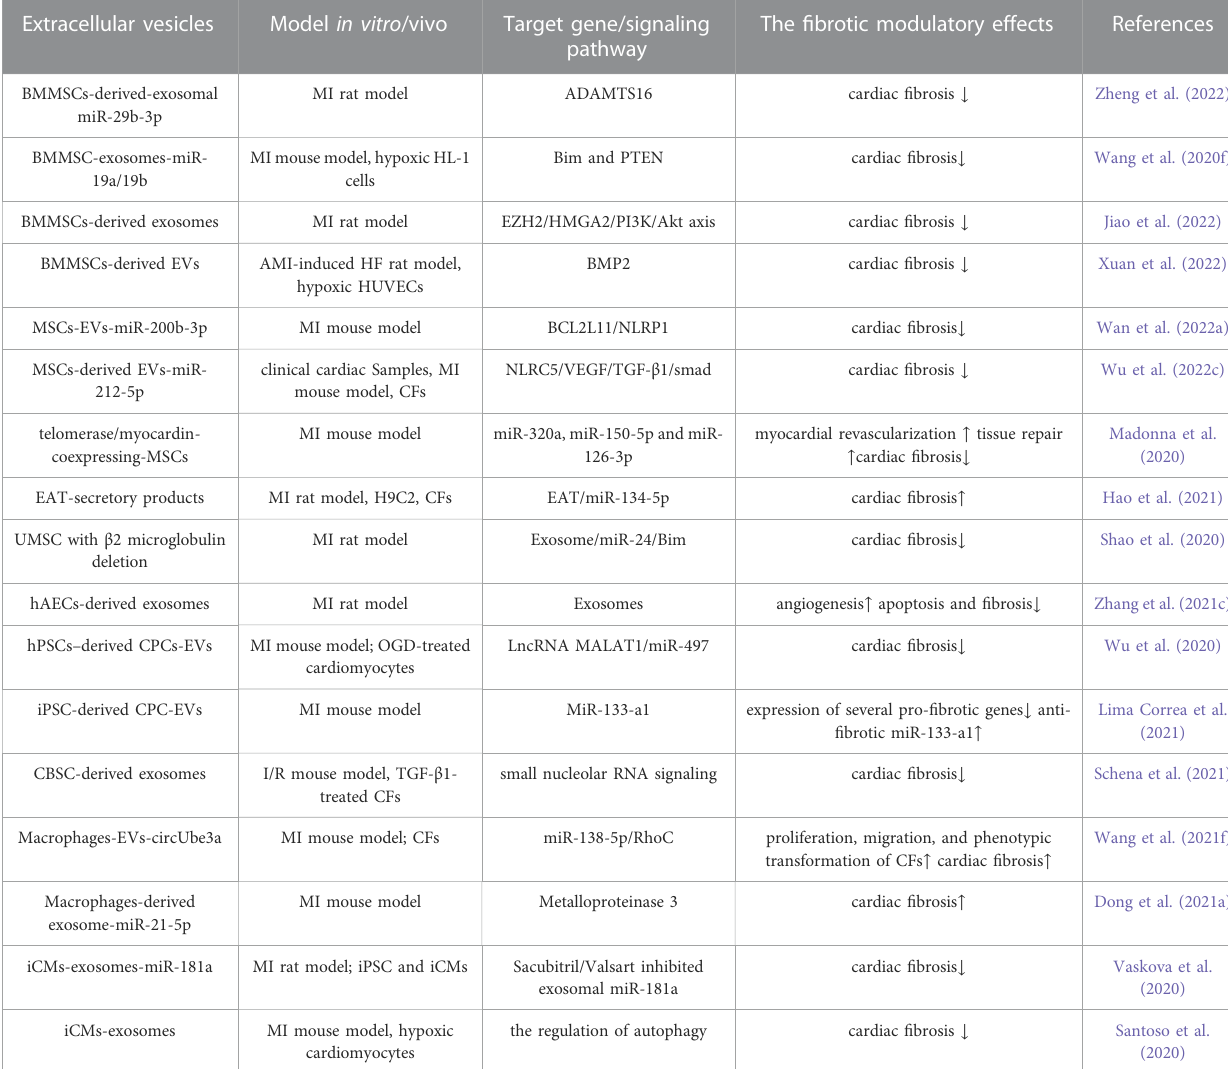
TABLE 2 The fi brotic modulatory effects of extracellular vesicles in myocardial infarction. Extracellular